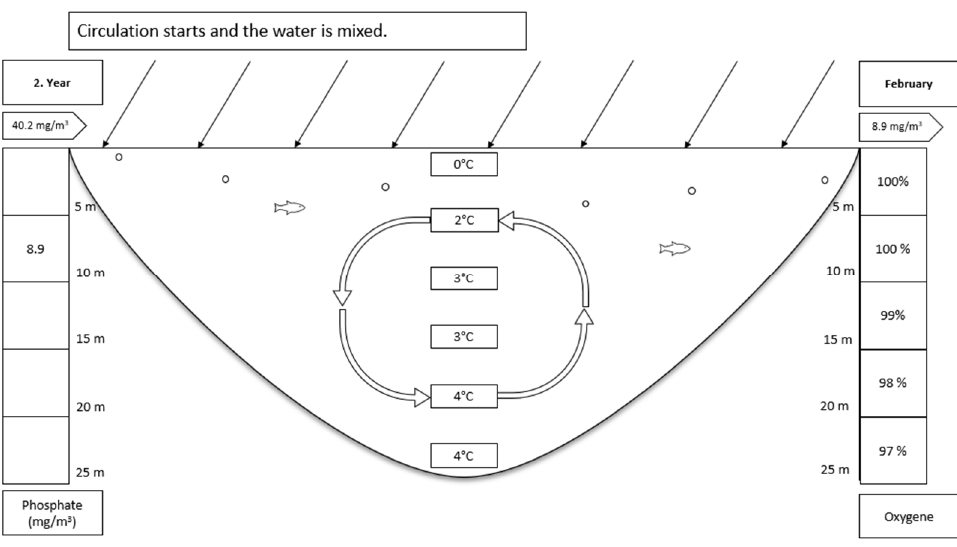
Figure 2. Sample screen from the learning material in experiment 1 (animation with written text).